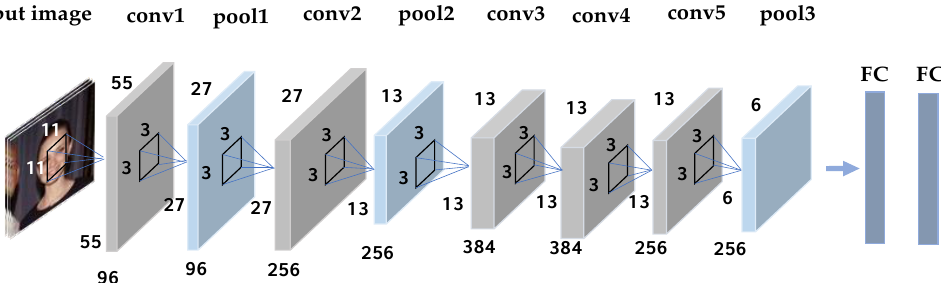
Figure 3. The CNN network structure consists of five convolution layers, three max-pooling layers, and two fully connected layers. The input is the scale-normalized